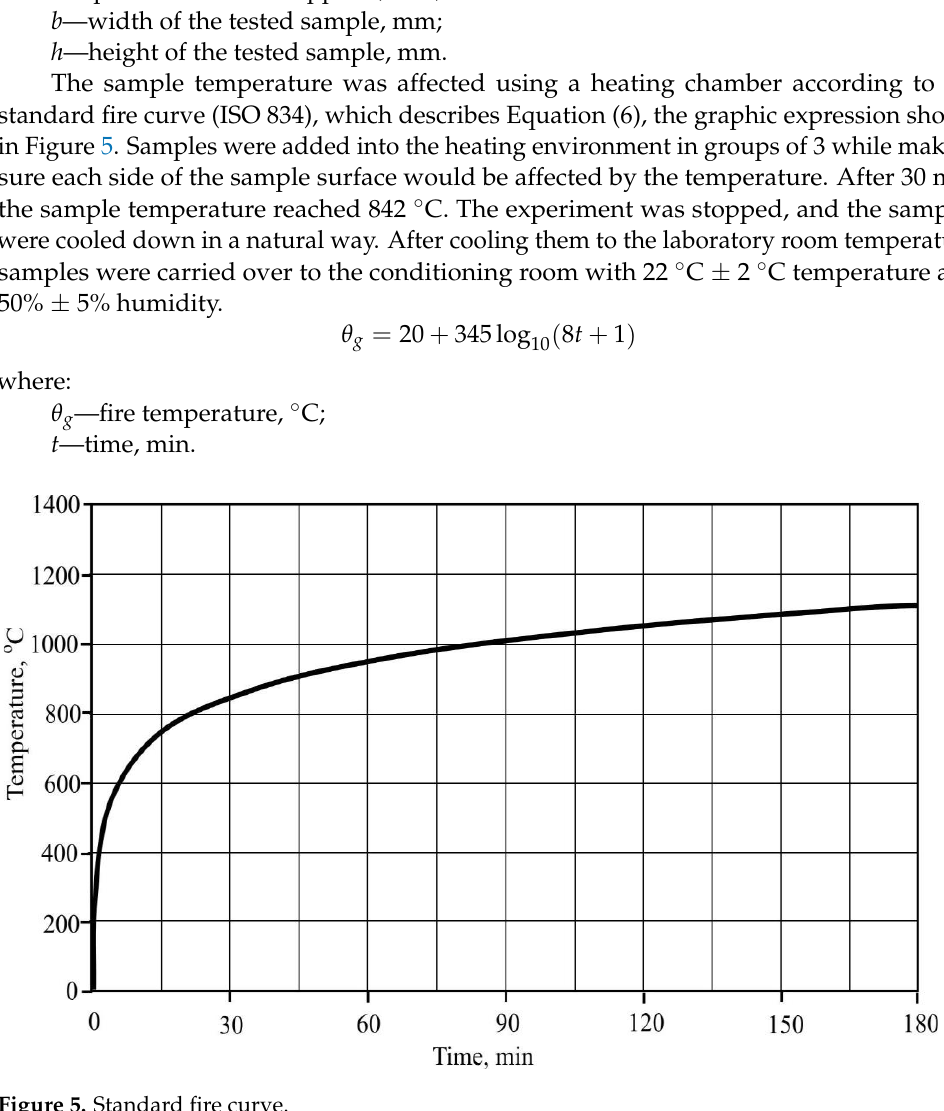
Figure 5. Standard fire